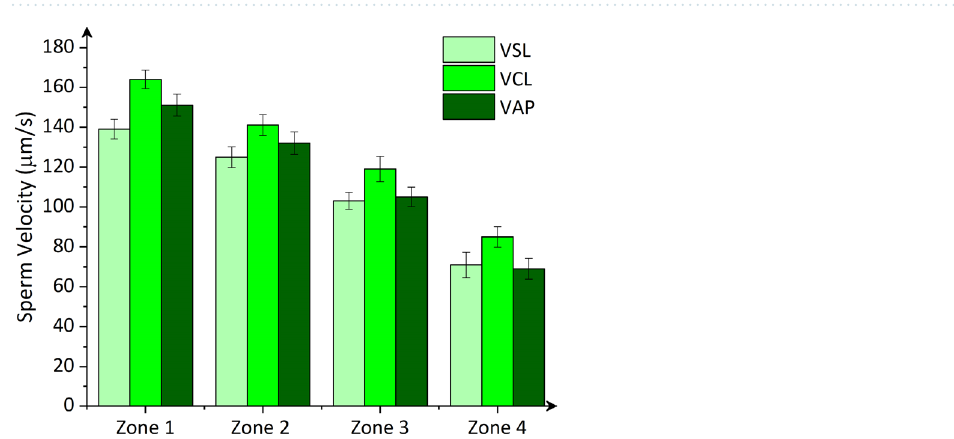
Figure 4. Image sequences of human sperm in the device, indicating the rheotaxis behaviour of motile sperm to swim into a representative micropocket. Swimming trajectories of 7 different sperm are depicted, with the trajectories starting at the solid black circles.